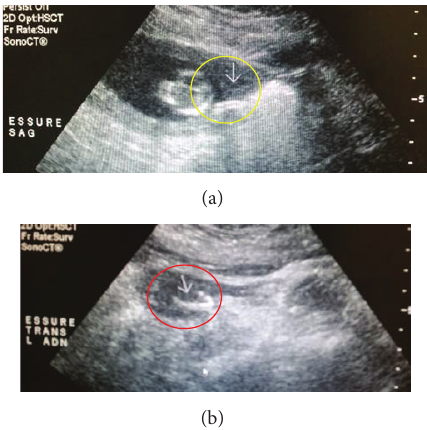
Figure 5: Patient number 2, pelvic sonogram on 4/2/15: showing right Essure inserts, sagittal view (yellow circle), and left Essure insert, transverse view (red circle).